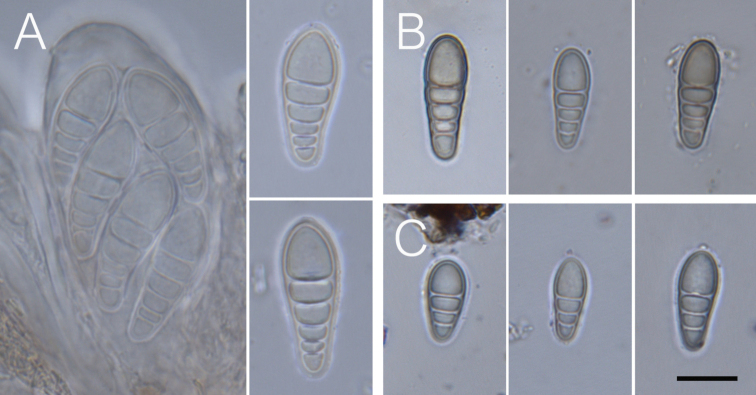
Ascospore morphology. AConiocarpon
cinnabarinum (TRH-L-29007) BConiocarpon
fallax (TRH-L-29008) CConiocarpon
cuspidans (TRH-L-29036). Scale bar: 10 µm.